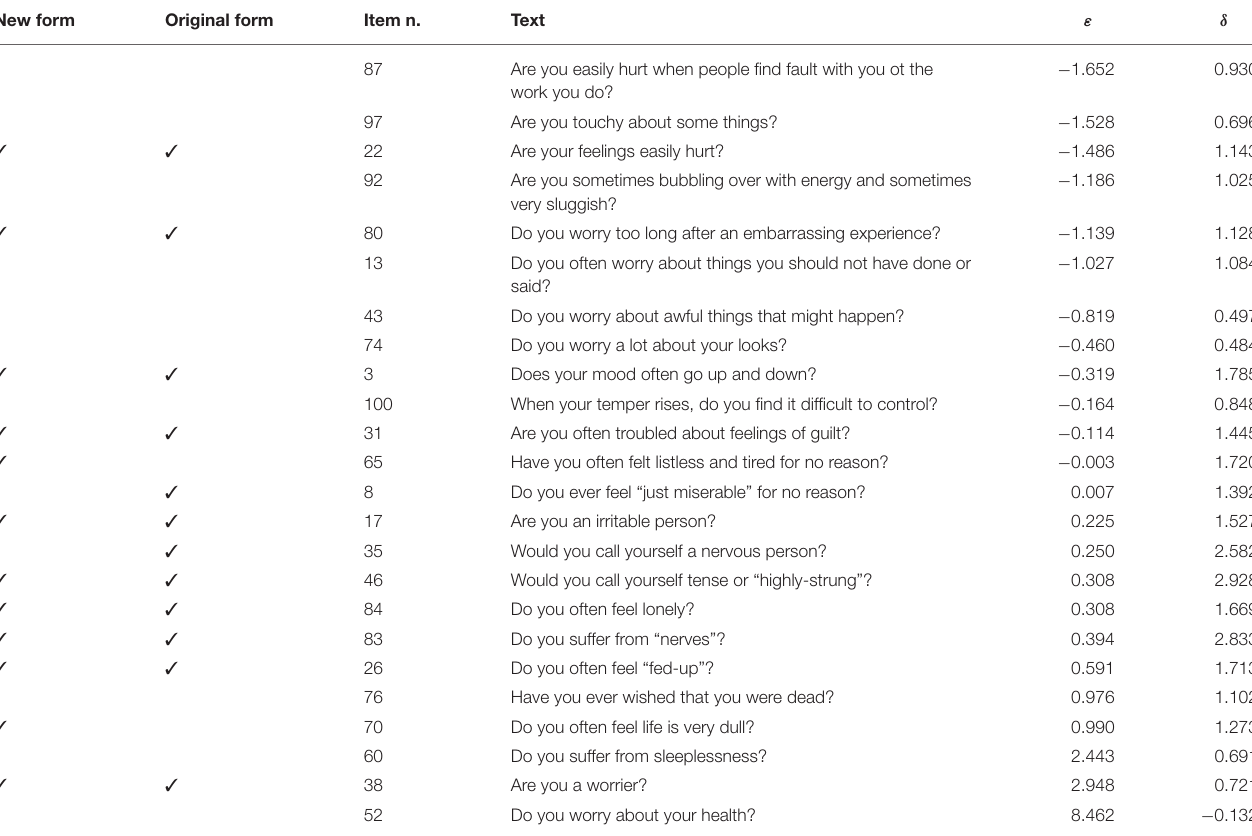
TABLE 3 | Easiness ( ε ) and discrimination ( δ ) parameters for the 24 items of the Neuroticism scale. New form Original form Item